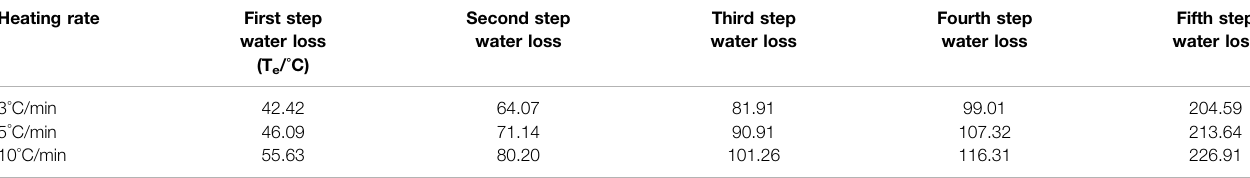
TABLE 3 | Extrapolated initial temperature by water loss of chalcanthite at different heating rates.